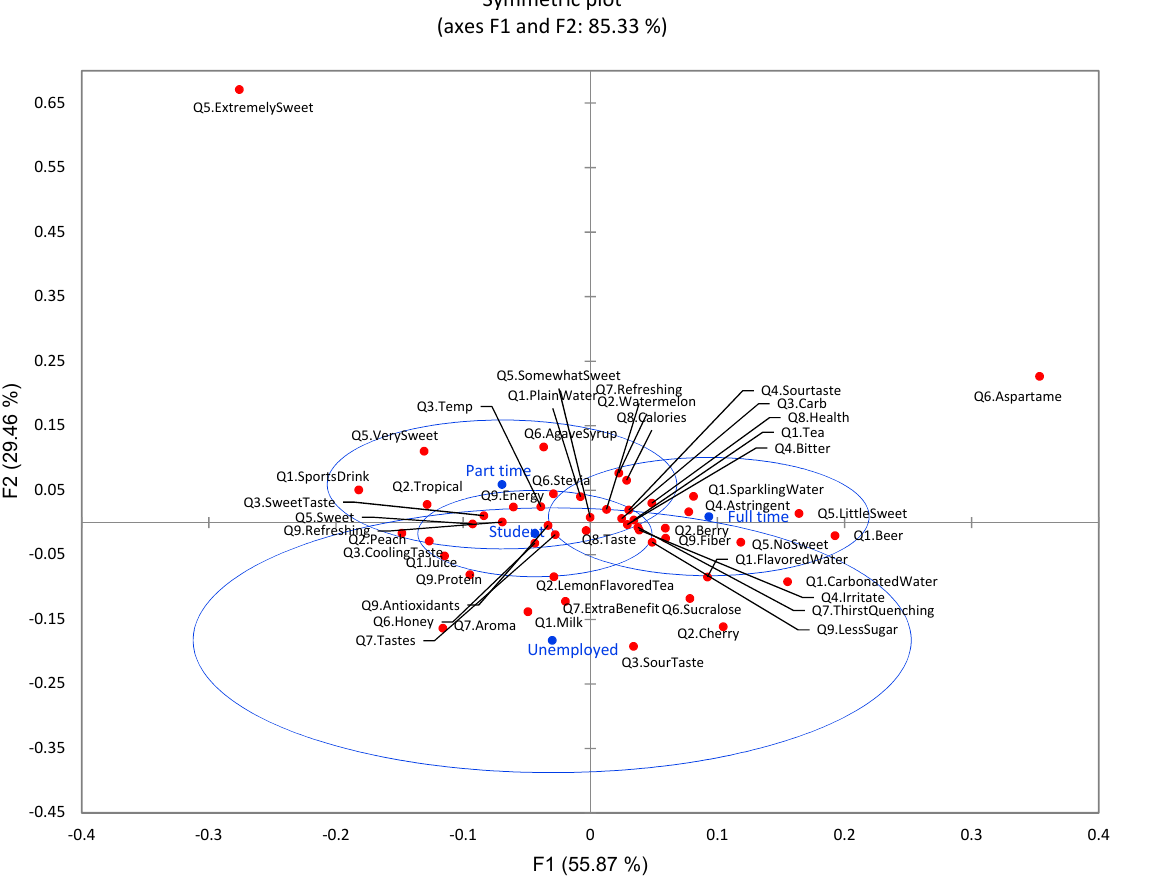
Figure 14. The first two dimensions of correspondence analysis (CA) symmetric plot using employ- ment status (college student, full time, part time, and unemployed) as Rows and all nine survey questions as Columns ( n = 901) (4 rows × 54 columns). Confidence ellipses on the plot were automat- ically created by XLSTAT software based on CA with observed χ 2 = 163.41 and p = 0.389.